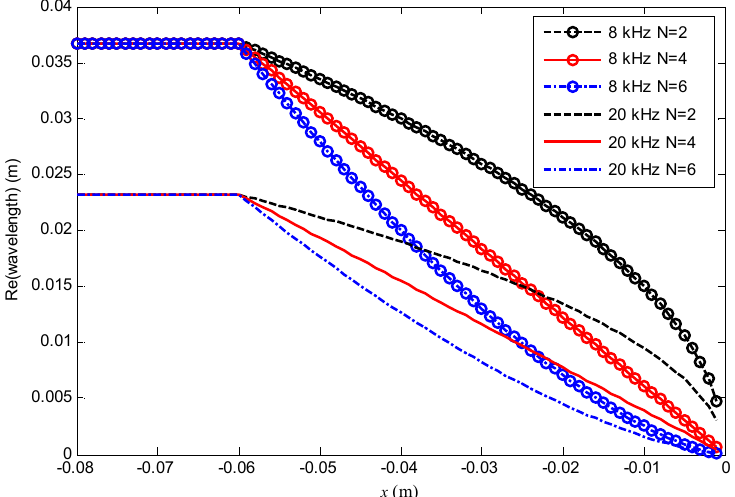
Figure 4. Real parts of the flexural wavelength along the x -axis at 8 and 20